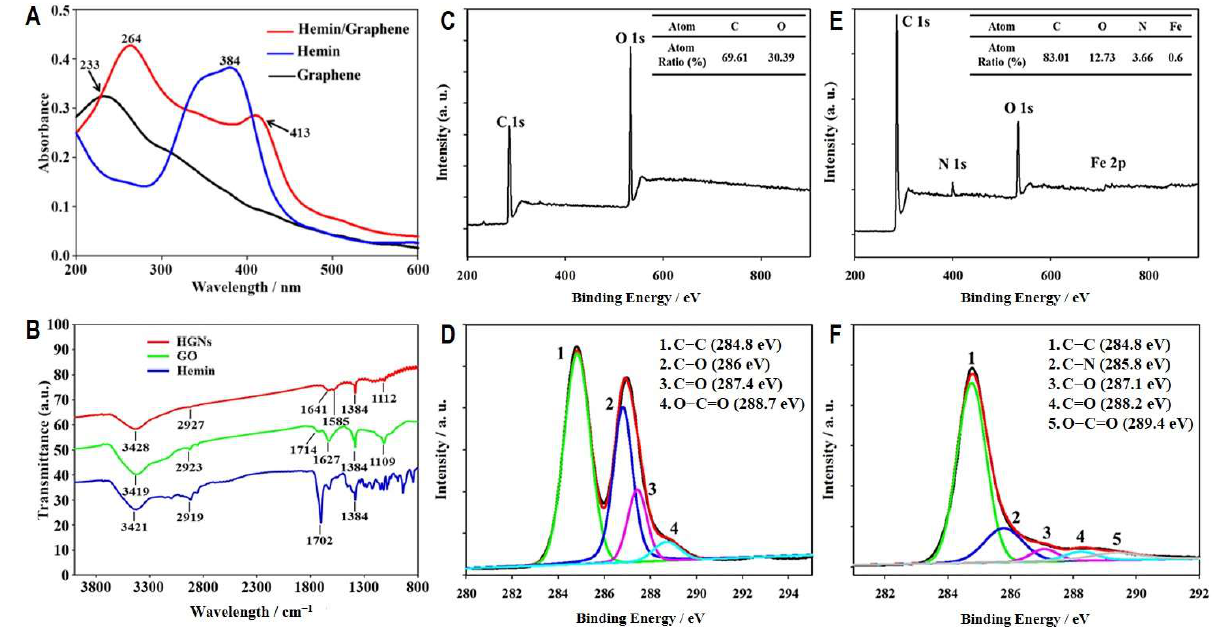
Figure 3. Characterization and analyses of HGNs to assess the conjugation of hemin onto the reduced graphene oxide. UV ( A ) and IR ( B ) absorption spectra of HGNs are compared with those of hemin and graphene oxide. Surface scanning patterns of graphene oxide and HGNs by X-ray photoelectron spectroscopy are shown in ( C ) and ( E ), respectively, and their carbon spectra are shown in ( D ) and ( F ), respectively.